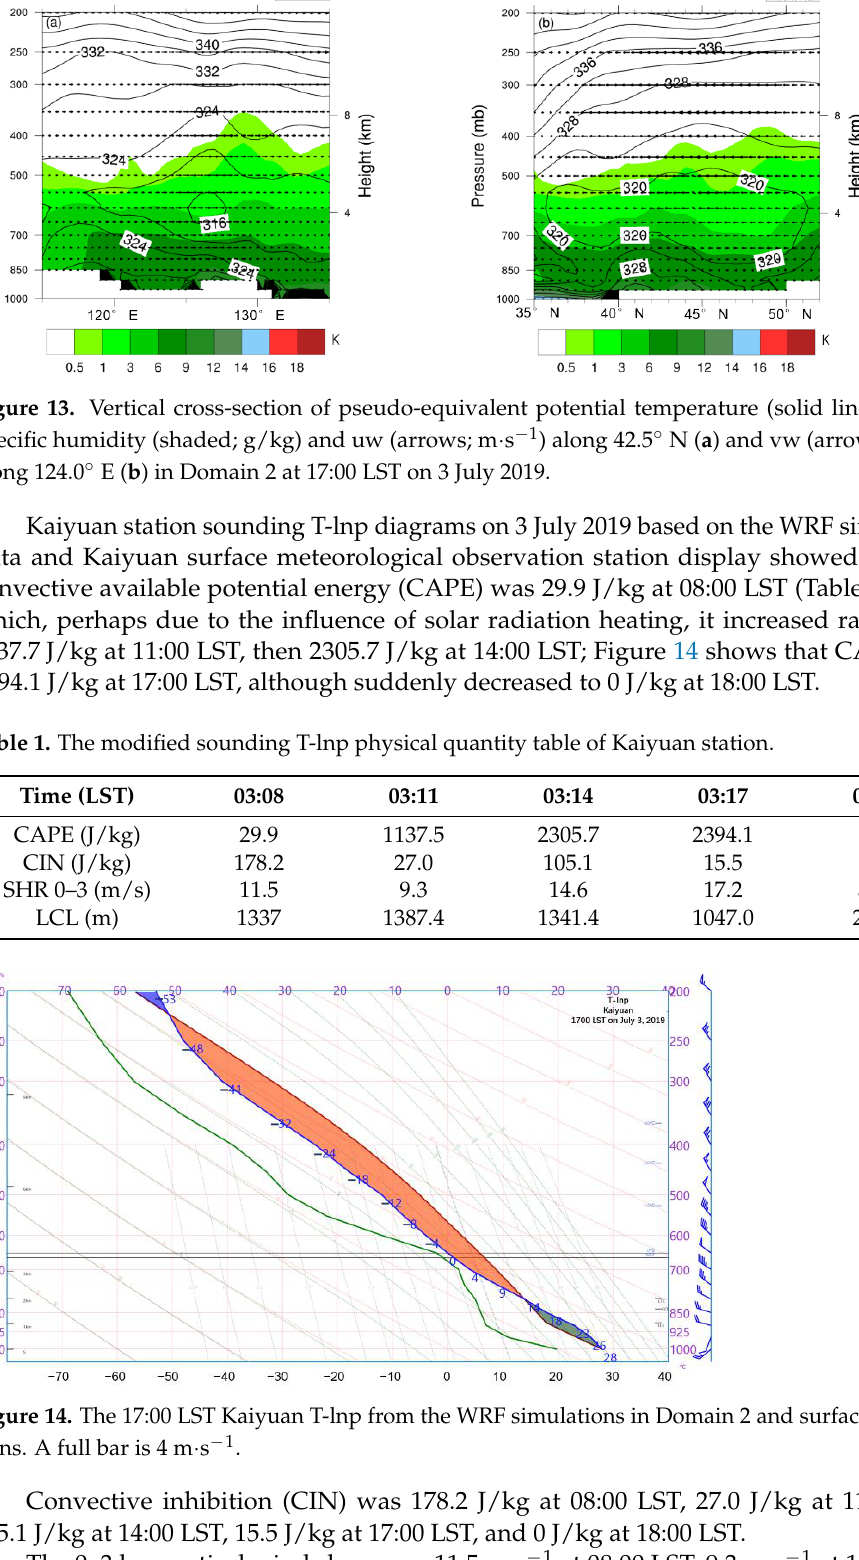
tive instability zone, with a low center between 125 and 127° E at 550 – 700 hPa; and the